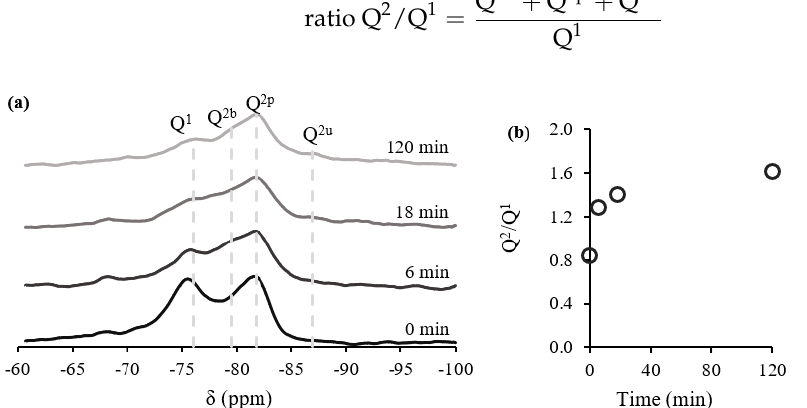
Figure 10. 29 Si NMR spectra ( a ), Q 2 /Q 1 ratio ( b ).